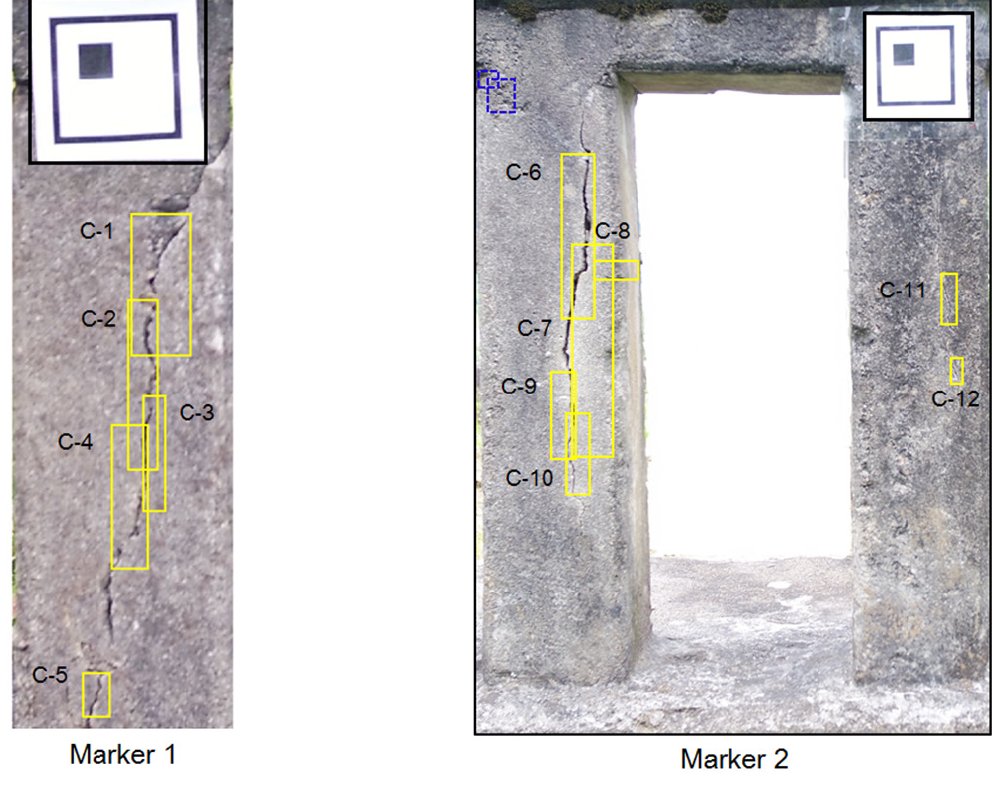
Figure 8. Results of crack (C)